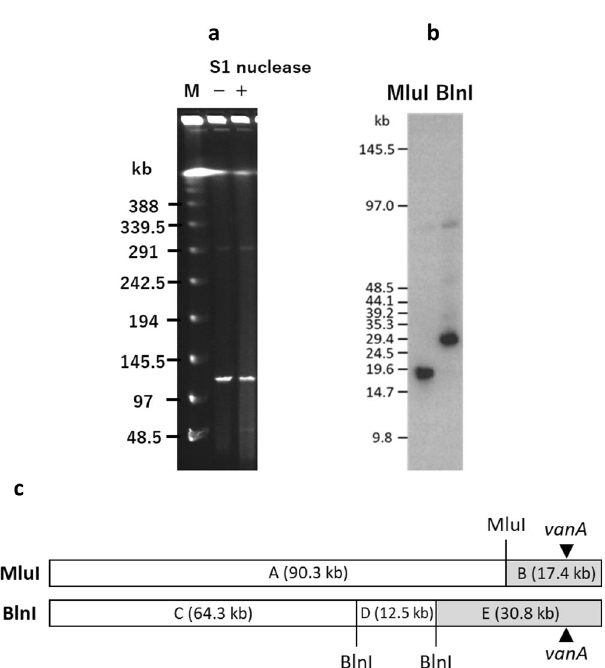
Figure 5. Molecular characterization of pIHVA, a linear plasmid. ( a ) Pulsed-field gel electrophoresis of S1 nuclease-treated and -untreated DNA of the vancomycin-resistant E. faecium S477 strain. M, molecular marker; +, S1 nuclease-treated; −, S1 nuclease-untreated. ( b ) Southern hybridization analysis of MluI and BlnI- treated DNA of the S477 strain with the vanA probe. ( c ) Restriction map of pIHVA (107 kb) is shown. A single MluI site and two BlnI sites are present in pIHVA. The fragments produced by digestion with these restriction enzymes are denoted by letters. The full-length gel and blot are presented in Supplementary Fig.